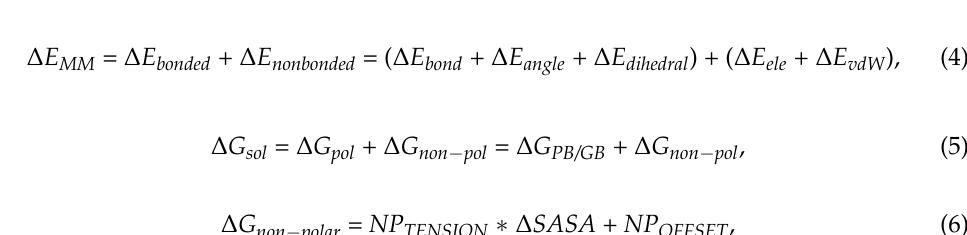
Figure S3: Root mean square deviation of each system in three 200 ns independent molecular dynam- ics simulation trajectories; Figure S4: Rg values of each system in three 200 ns independent molecular dynamics simulation trajectories; Figure S5: SASA values of each system in three 200 ns independent molecular dynamics simulation trajectories; Figure S6: ATP binding free energy curves of each system in three 200 ns independent molecular dynamics simulation trajectories; Figure S7: DNA binding free energy curves of each system in three 200 ns independent molecular dynamics simulation